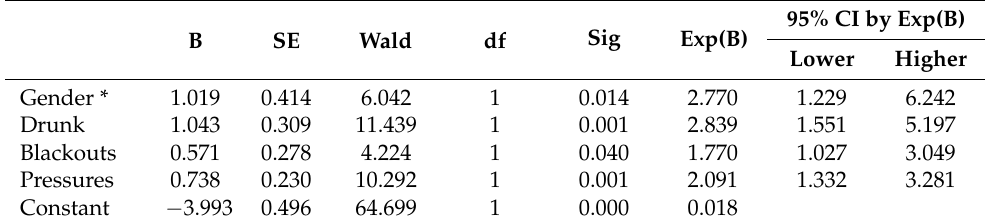
Table 5. Regression analysis of sexual violence: gender, drunk episodes, blackout episodes and pressures to consume